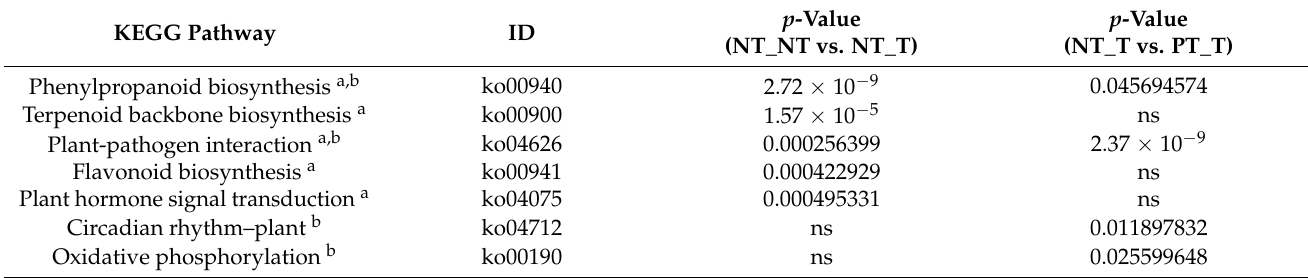
Table 1. KEGG pathway enrichment of DEGs in NT_NT vs. NT_T and NT_T vs.